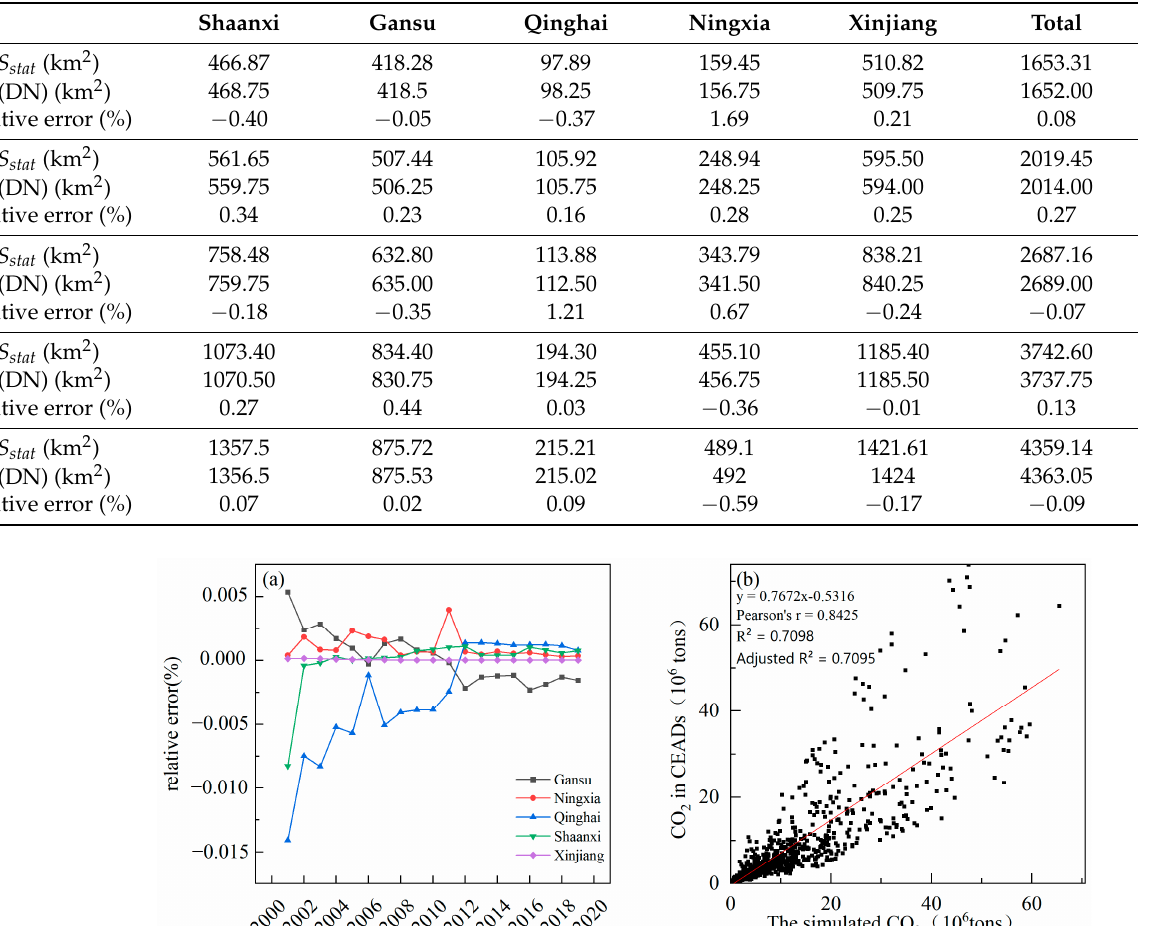
Figure 3. ( a ) Relative error between stimulated CE and CE calculated based on the statistical yearbook. ( b ) Fitting accuracy between stimulated CE and CE published on CEADs.